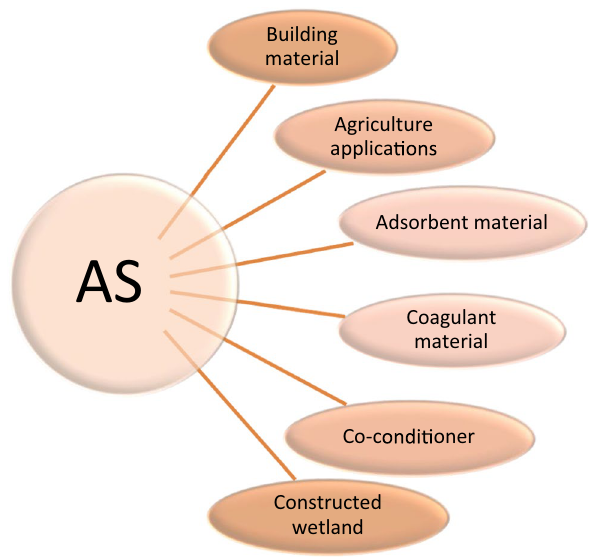
Fig. 6 Summary of the sustainable AS